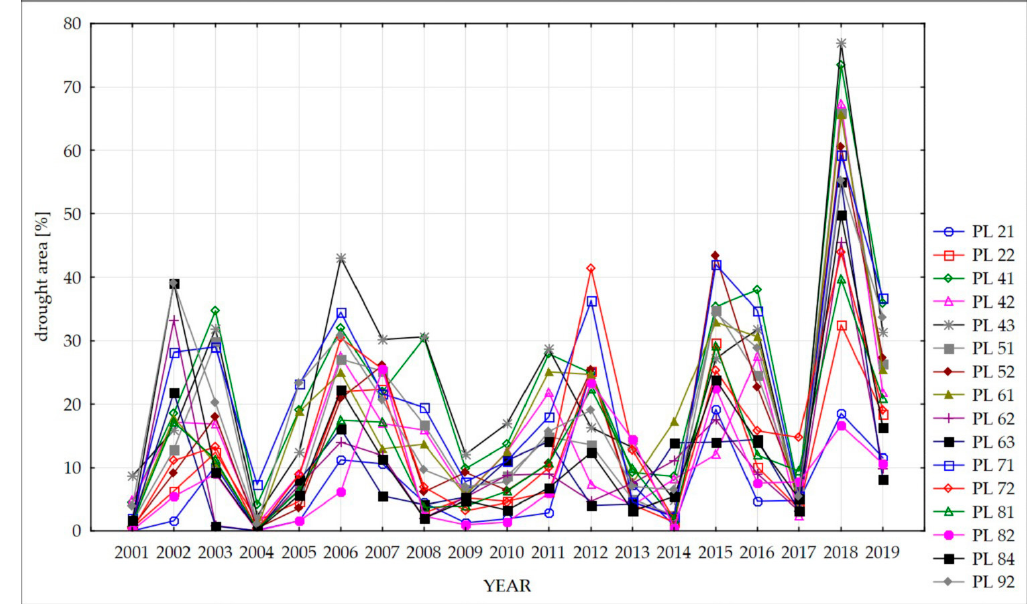
Figure 22. Percentage of drought area occurrence in Poland (2001–2019).